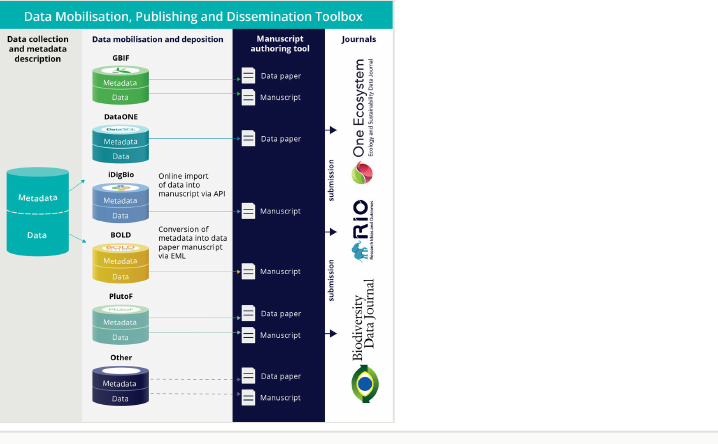
Figure 6. Data and metatada import into manuscripts in ARPHA Writing